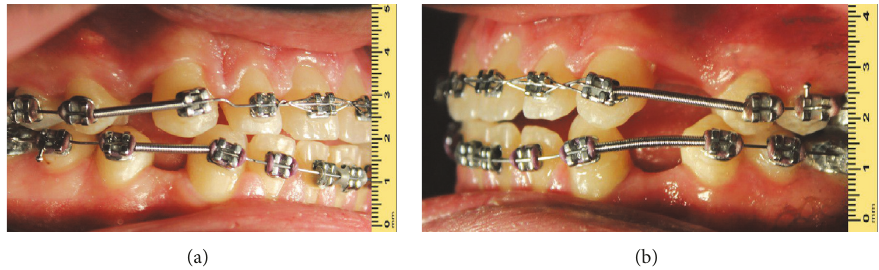
Figure 2: Intraoral view with fixed orthodontic appliance showing missing teeth and diastema. (a) Right side. (b) Left side.